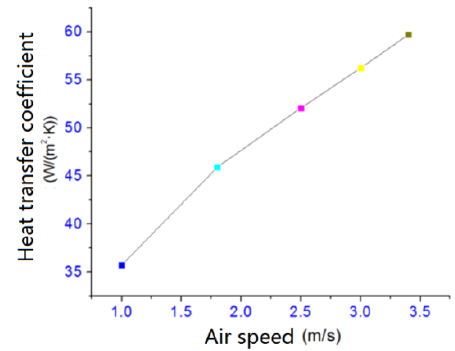
Fig. 3. Effect of air speed on heat transfer coefficient.